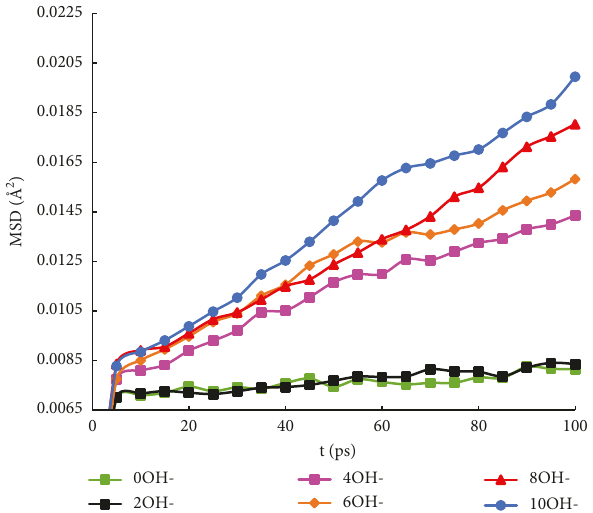
Figure 9: MSD of calcium in different alkaline